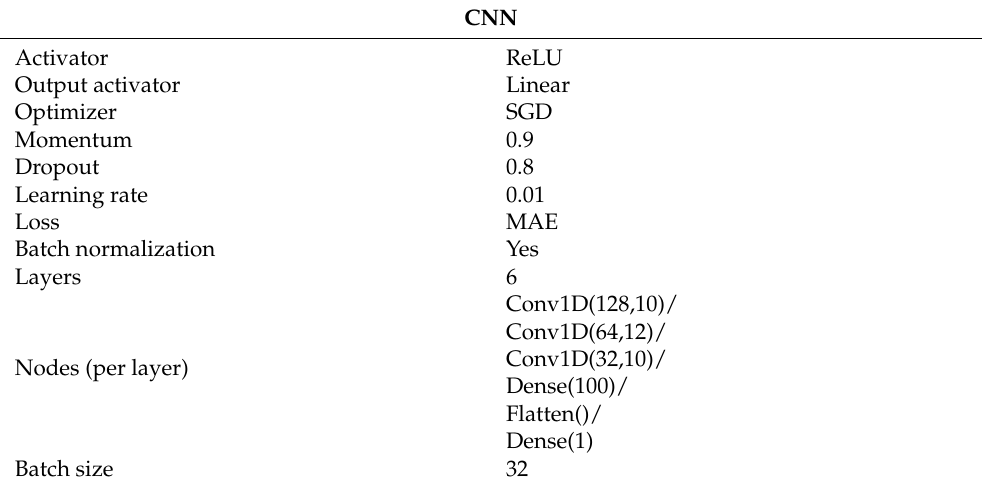
Table 7. DNN regression model